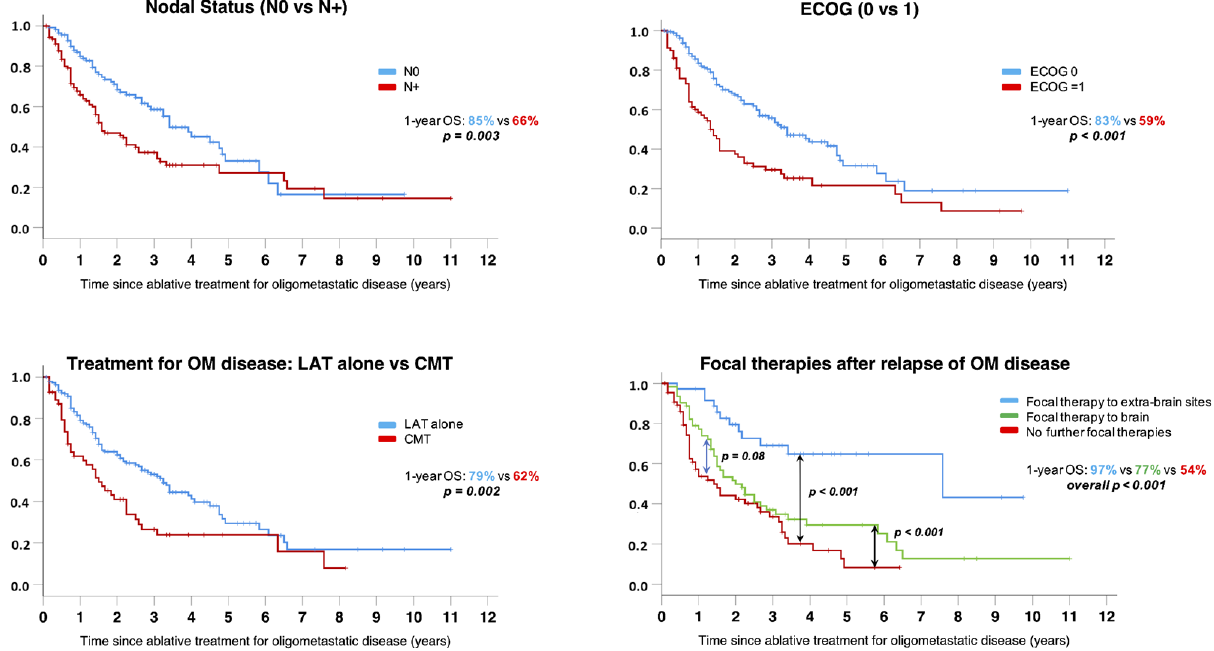
Figure 3. Subgroup analysis showing OS Kaplan–Meier curves stratified for the following variables: Nodal involvement (upper left chart), ECOG PS (upper right chart), addition of chemotherapy (CMT) to LAT (lower left chart) and the delivery of any further local treatment for relapse/progression after LAT (lower right chart).